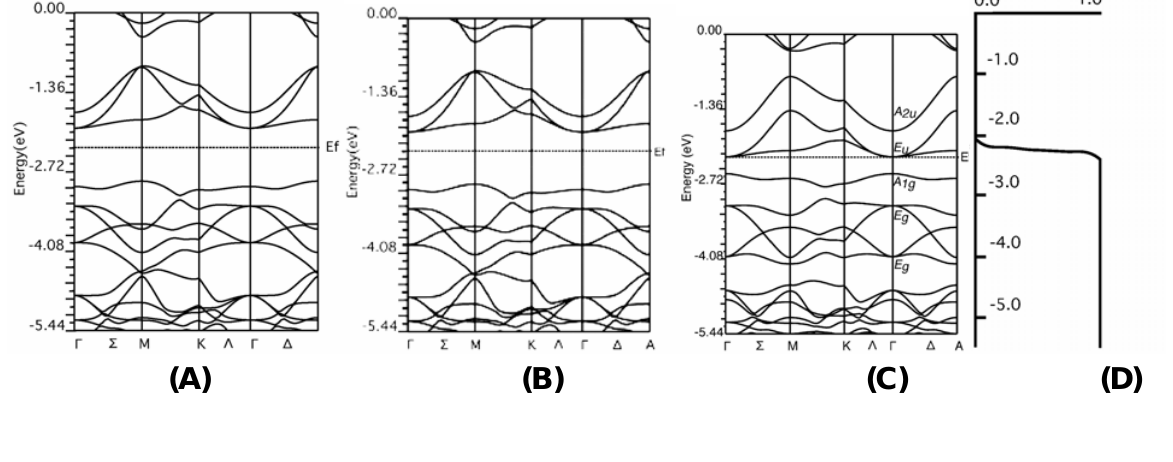
Table 3. Calculated band gaps * (E